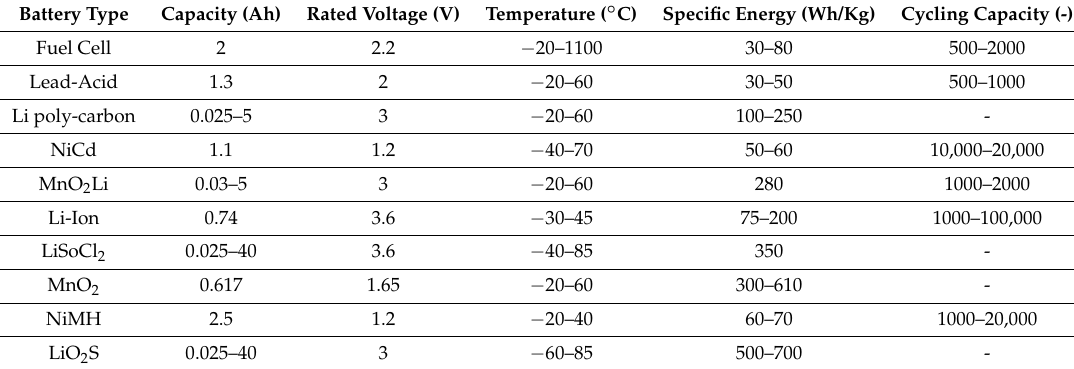
Table 5. Parameters of energy storage devices